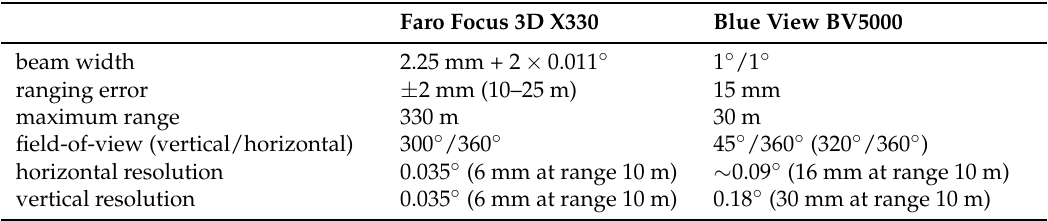
Table 1. Manufacturer’s specification of the acquisition devices (top lines) and recording resolutions used for the experiment (two bottom